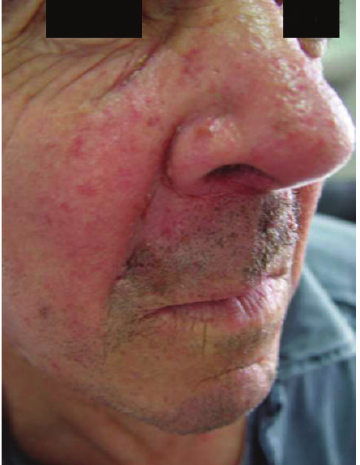
Figure 4: Regression of the lesions after 7 months of treatment with